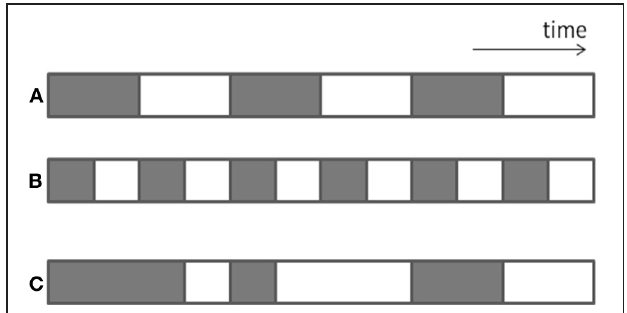
FIGURE 1 | Graphical representation of differences in distribution of length of bouts and variability in bout length. The gray bars indicate sedentary behavior